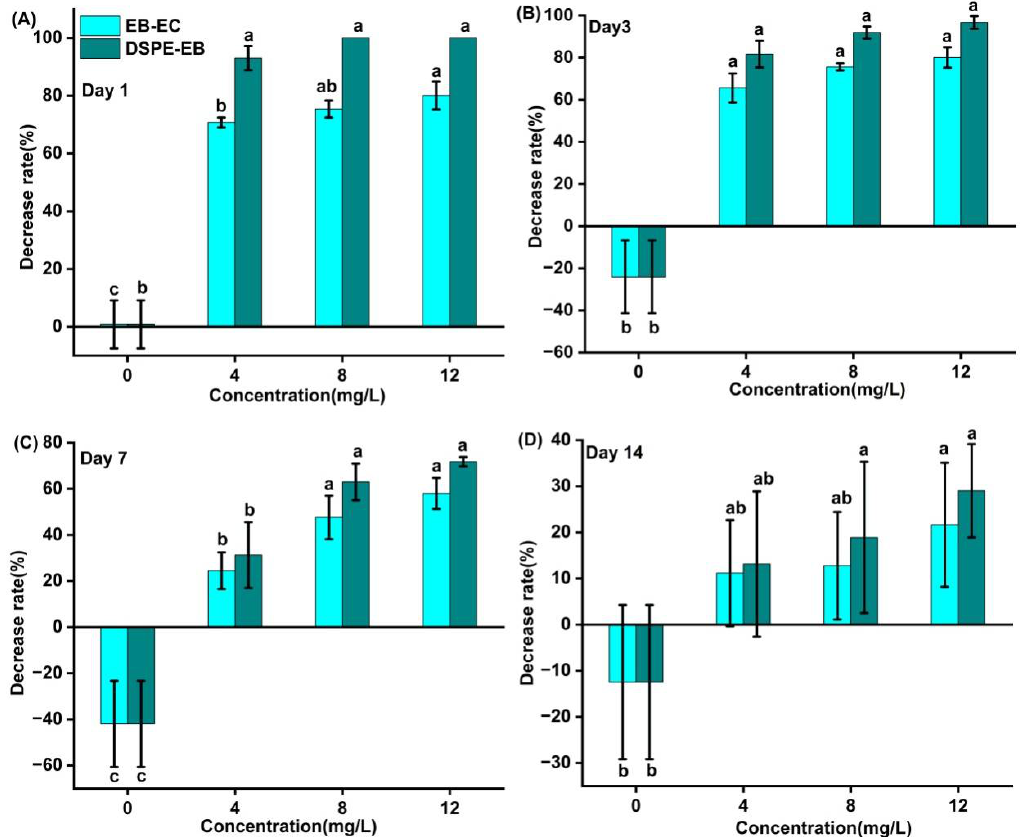
Figure 7. Decrease rates of different concentrations of EB-EC and DSPE-EB nanoparticles against S. furgiperda larvae at 1 ( A ), 3 ( B ), 7 ( C ), and 14 d ( D ) after spraying under field conditions. Different letters at each data indicate significant differences according to Duncan’s multiple range test at p < 0.05. In all the above data, the error bars represent the standard errors of the means of three replicates.